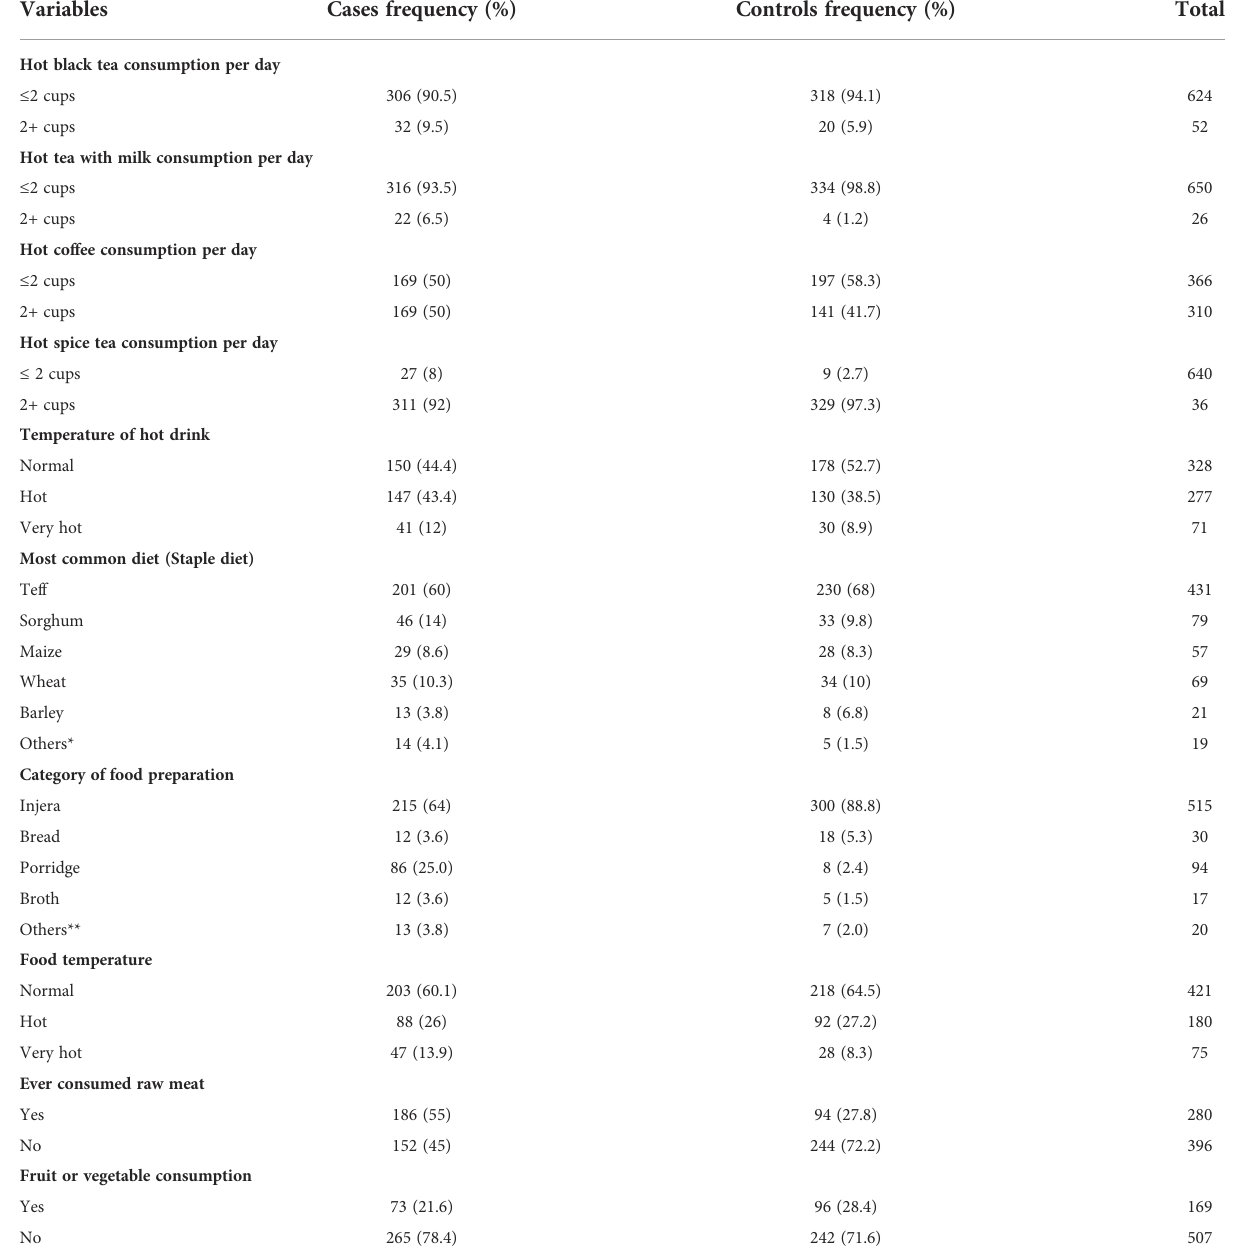
TABLE 3 Hot beverage and dietary characteristics of cases and controls February 2019-August 2020, Addis Ababa, Ethiopia. Variables Cases frequency